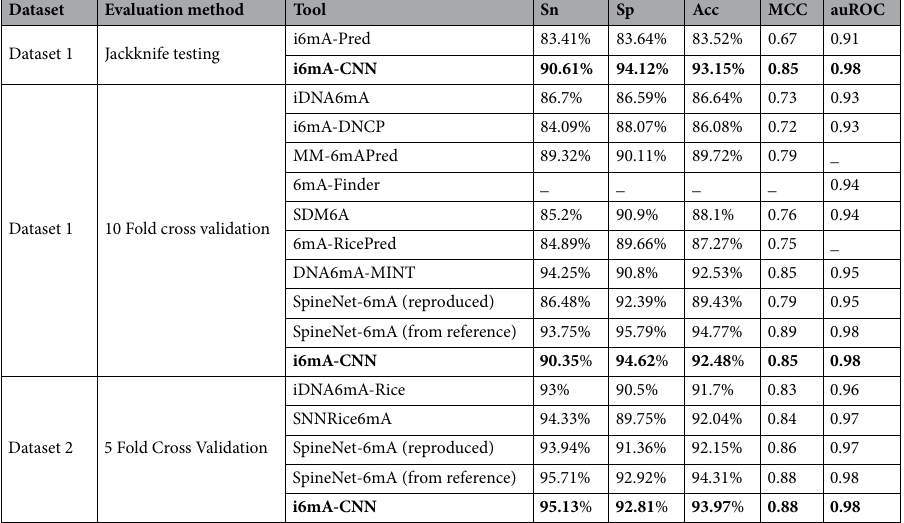
Table 4. i6mA-CNN performance (marked in bold) comparison with state-of-the-art tools 22 . Dataset 1 is the 880 sample per class dataset used for comparison purpose, while Dataset 2 is our benchmark dataset with 1,54,000 samples in each class. There are two results provided for SpineNet-6mA tool for both datasets—one obtained from reproducing the research and the other obtained from the reference research paper.